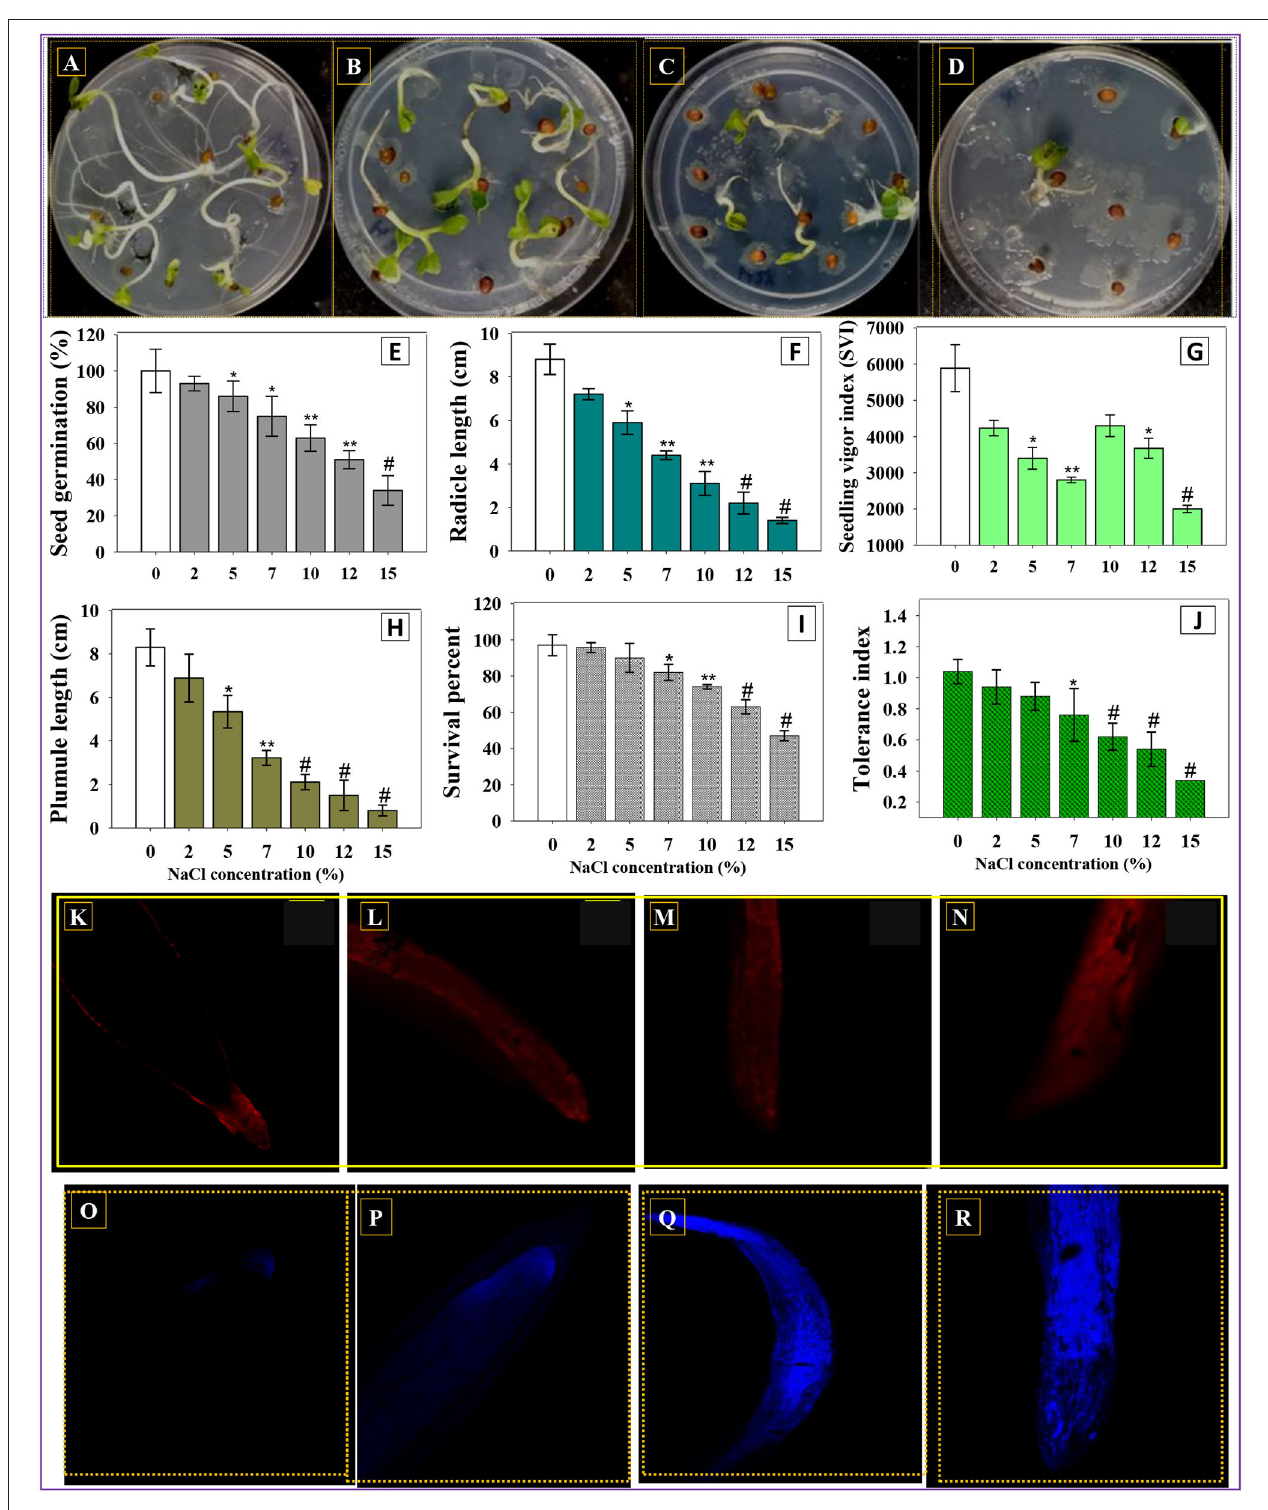
FIGURE 1 | R. sativus seeds germinated on soft agar plates treated with 0% (A) , 5% (B) , 10% (C) , and 15% NaCl (D) . Effect of different rates of NaCl on germination efficiency (E) , radical length (F) , vigor index (G) , plumule length (H) survival (I) , and tolerance index (J) of R. sativus seeds grown on soft agar plates in vitro . (K–R) represent the CLSM images of NaCl-induced permeability and cellular death in root tissues of radish treated with 7, 10, 12, and 15% NaCl, respectively. In this figure, bar diagrams represent the mean values of three replicates ( n = 3). Corresponding error bars represent standard deviation (S.D) of three replicates (SD, n = 3). The asterisks *, **, and # denote statistical significance at p < 0.05, p < 0.005 and p < 0.001, respectively, computed by Student’s T -test.